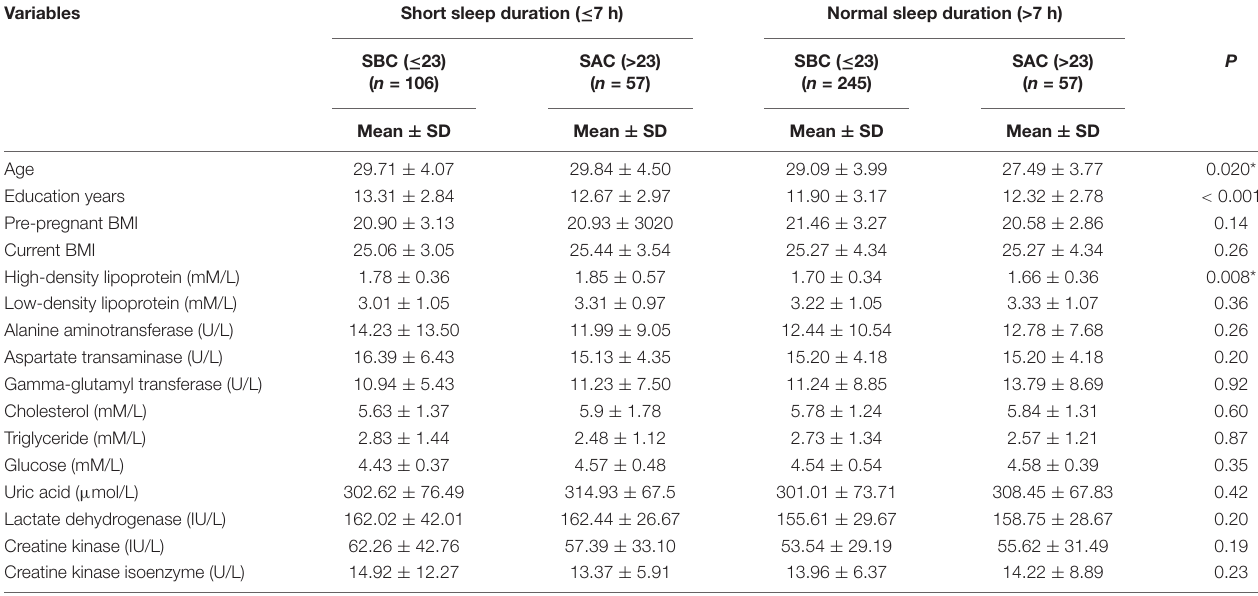
TABLE 1 | The differences in clinical characteristics between groups.